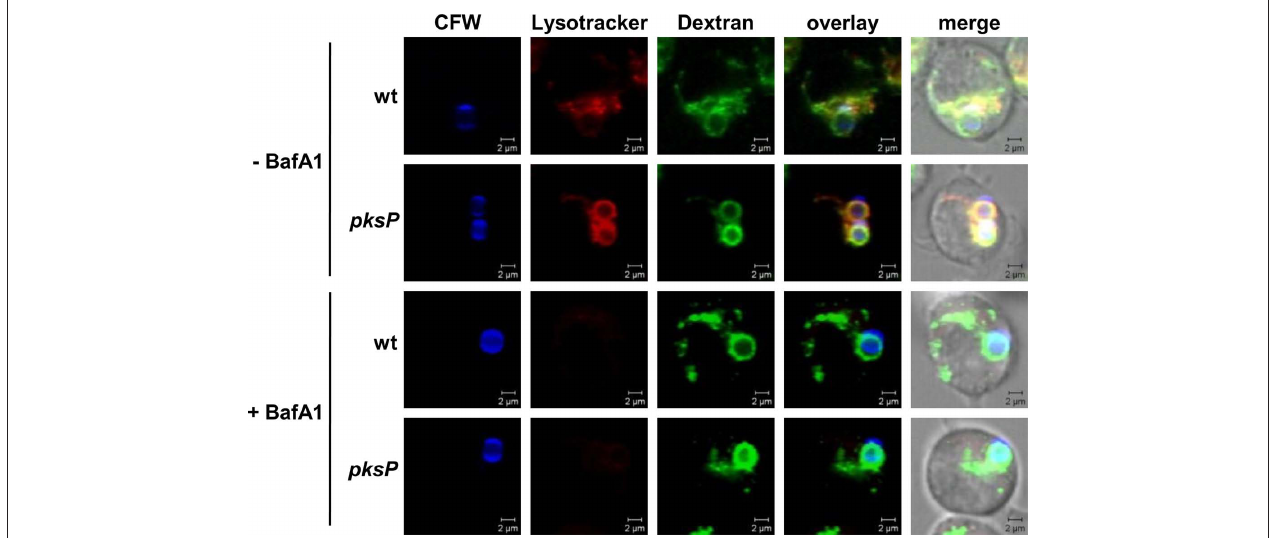
FiguRe 7 | effect of bafilomycin A1. Lysosomes were loaded with Oregon Green (OG) 488-Dextran. Colocalization of calcofluor white (CFW)-stained conidia (blue) with OG488 (green) showing fusion of phagosomes with lysosomes. Acidification of phagolysosomes was monitored by LysoTracker (red). Images show representative microscopic pictures. Size bar,